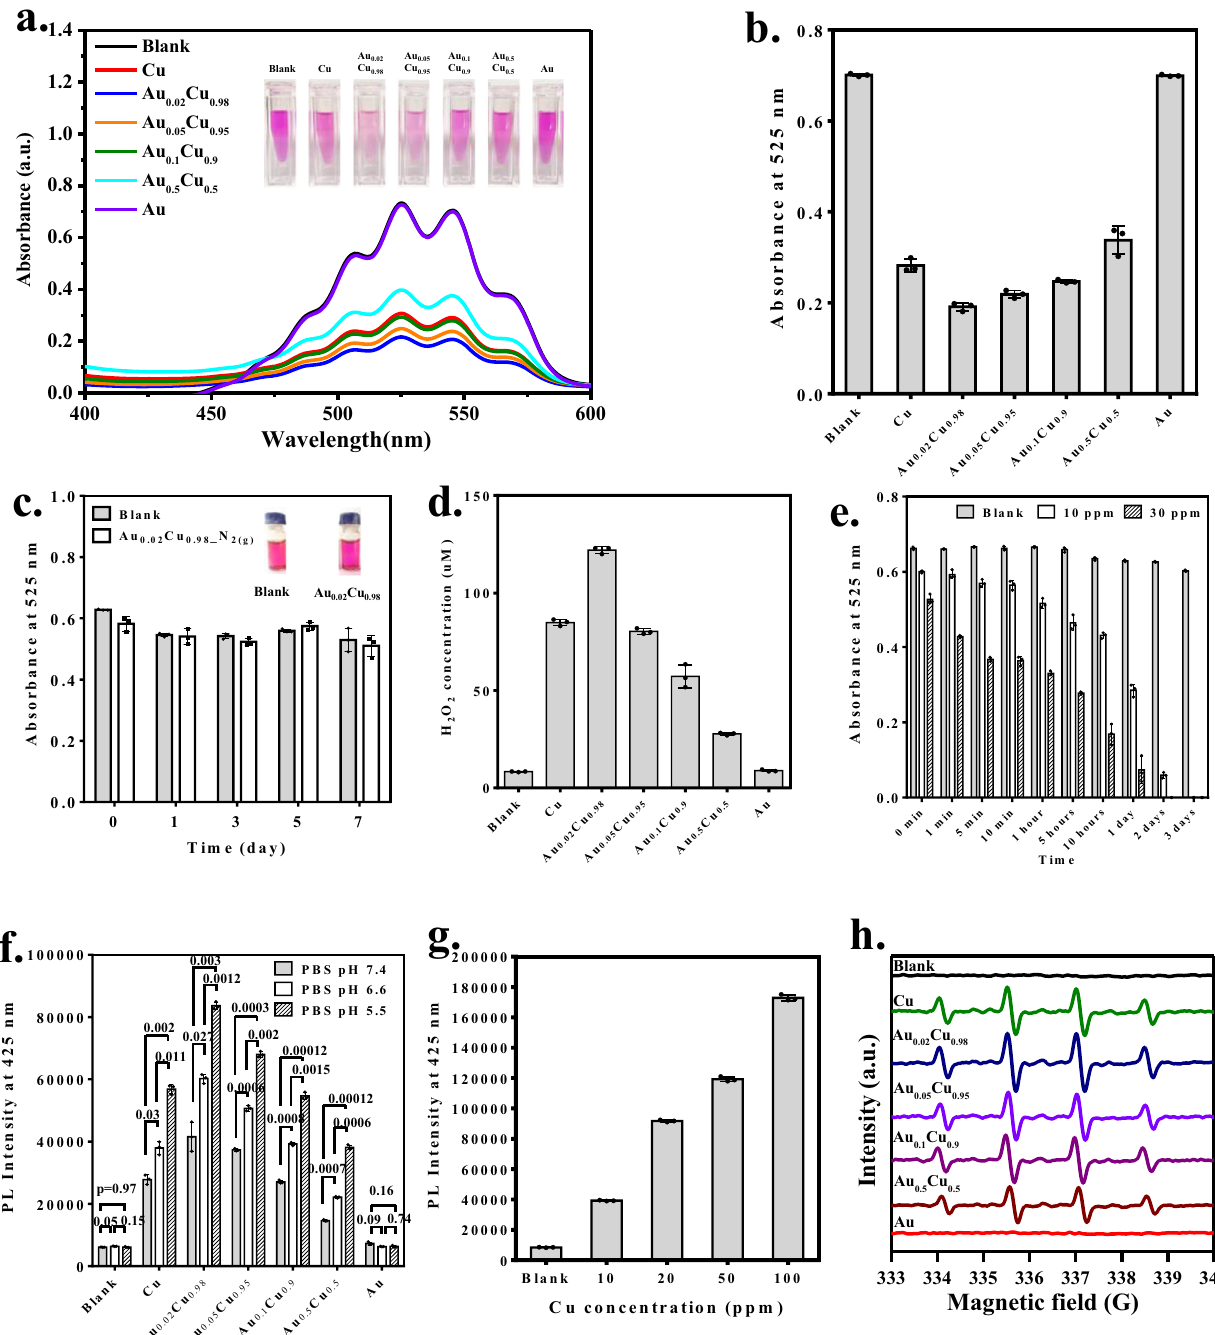
C u concentration (ppm )